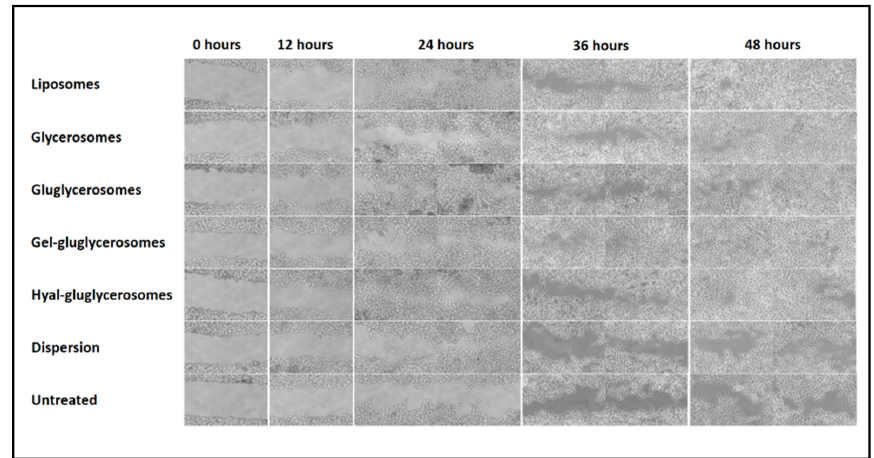
Figure 7. Representative optical microscopy images at different time points (0, 12, 24, 36, and 48 h) of the wound induced in keratinocytes and treated with H. scruglii extract in dispersion or loaded in vesicles. Bars correspond to 200 µ m.